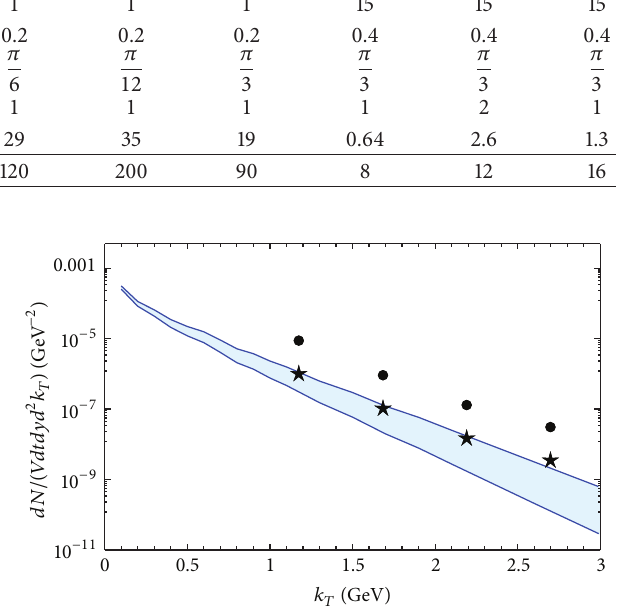
Figure 19: Variation of the synchrotron spectrum with plasma temperature. Lower line: 𝑇 = 200 MeV, upper line: 𝑇 = 250 MeV; Other parameters are the same as in Figure 18(a). Adopted from